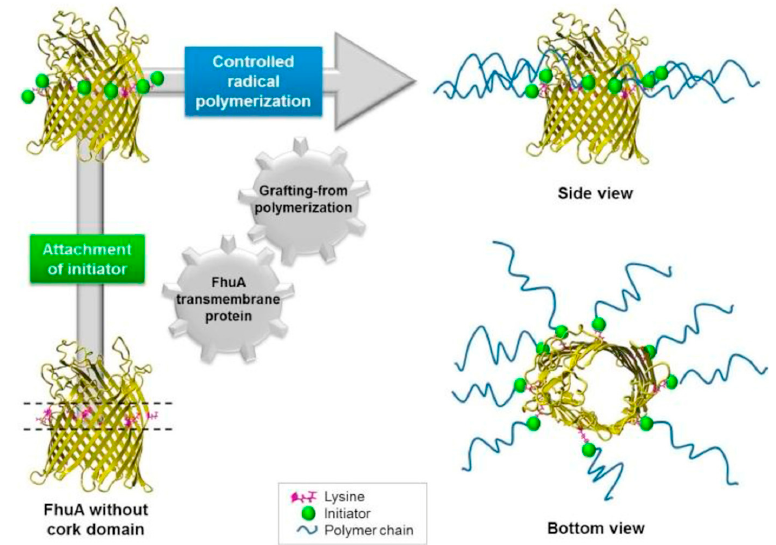
Figure 20. Representation of polymerization of NIPAAm by using β -barrel membrane protein (ferric hydroxamate uptake protein component A, FhuA) with ATRP initiating sites and “grafting from” strategy. Reprinted with permission from Reference [27]. Copyright © 2016 Elsevier Ltd. (Amsterdam, The Netherlands).